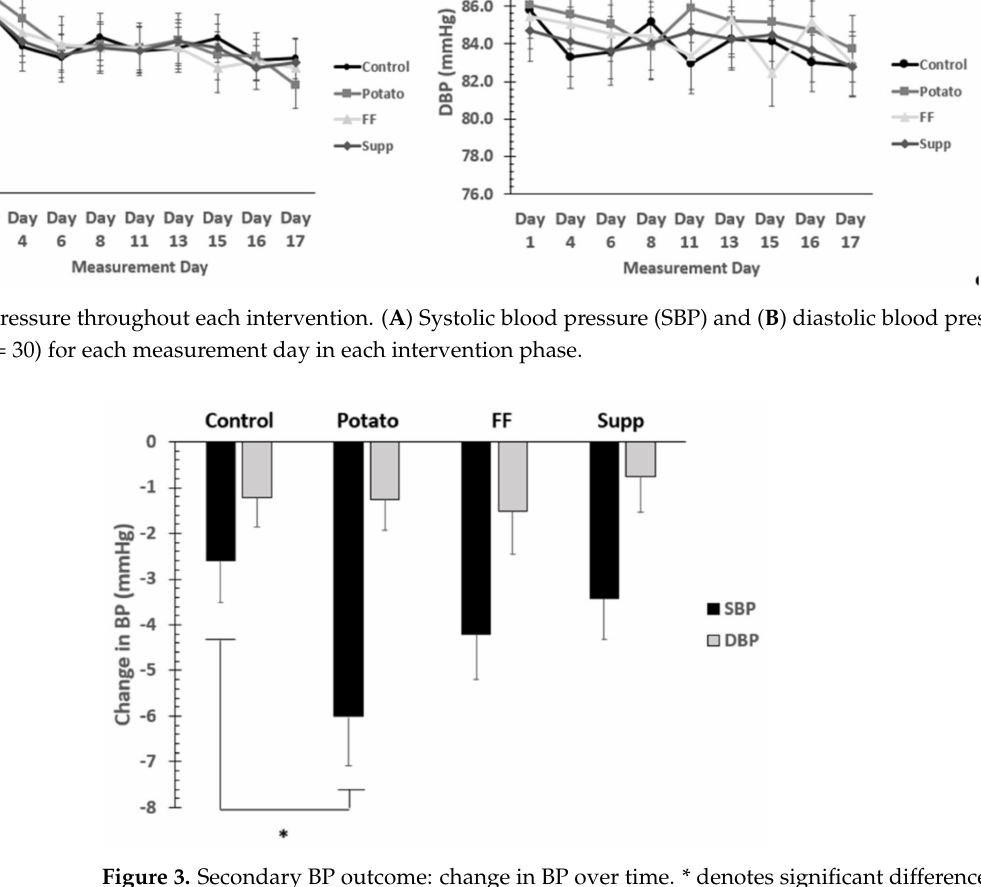
Figure 3. Secondary BP outcome: change in BP over time. * denotes significant difference ( p < 0.05) between potato and other groups.